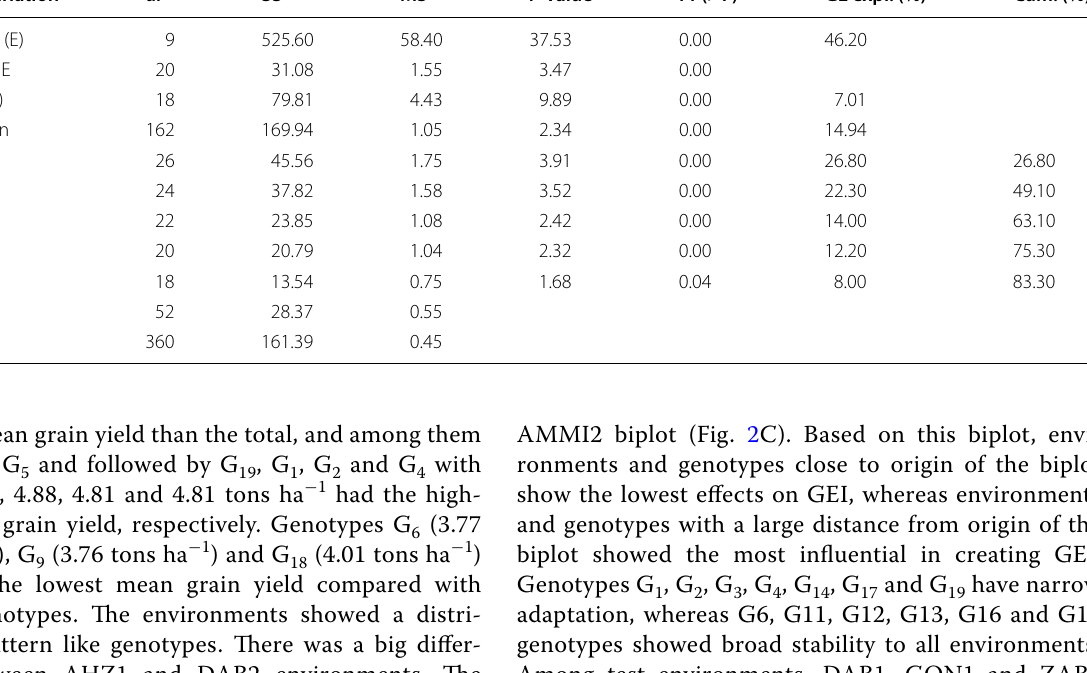
Table 2 AMMI analysis of variance for grain yield (tons ha –1 ) at five locations in Iran, during 2018–2020 cropping seasons Source of